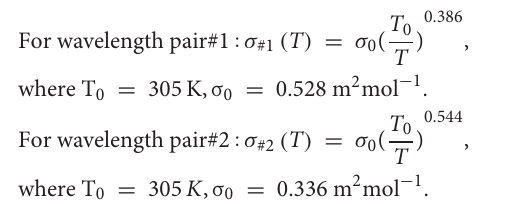
derived for the two selected wavelength pairs.